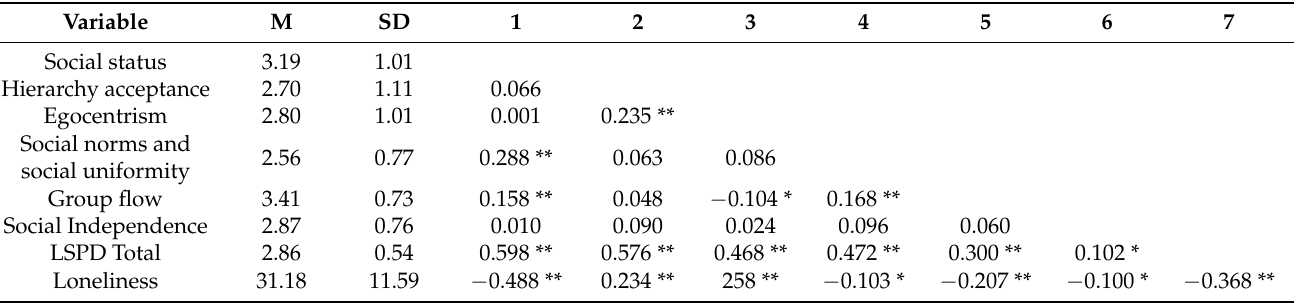
Table 3. Means, standard deviations, and Spearman correlations between study